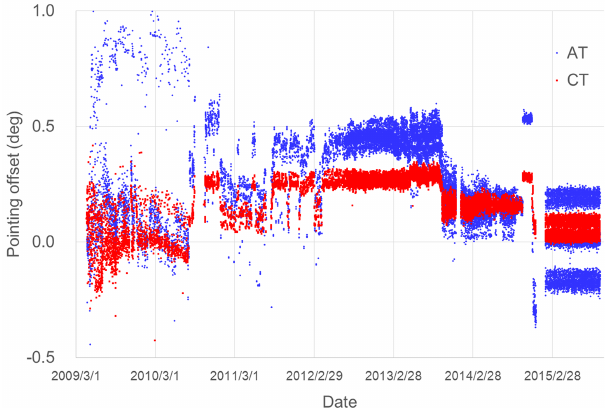
Figure 7. Long-term pointing offset for grid observations: AT opti- cal angle (blue circle) and CT (red square). Since August 2010, the grid observation pattern has changed from the five-point CT mode to the three-point CT scan mode. From 23 January 2015, the sec- ondary pointing system is